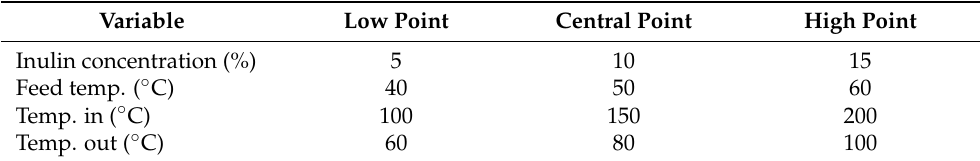
Table 1. Experimental face-centered central composite design (CCD). Independent variables and